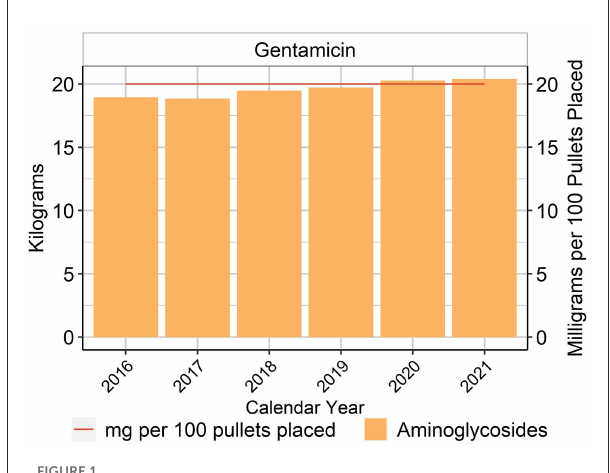
FIGURE1 Gentamicin used in layer hatcheries, 2016–2021. Total kilograms are shown by the bars (left Y-axis) and total milligrams/100 birds placed are shown by the line (right